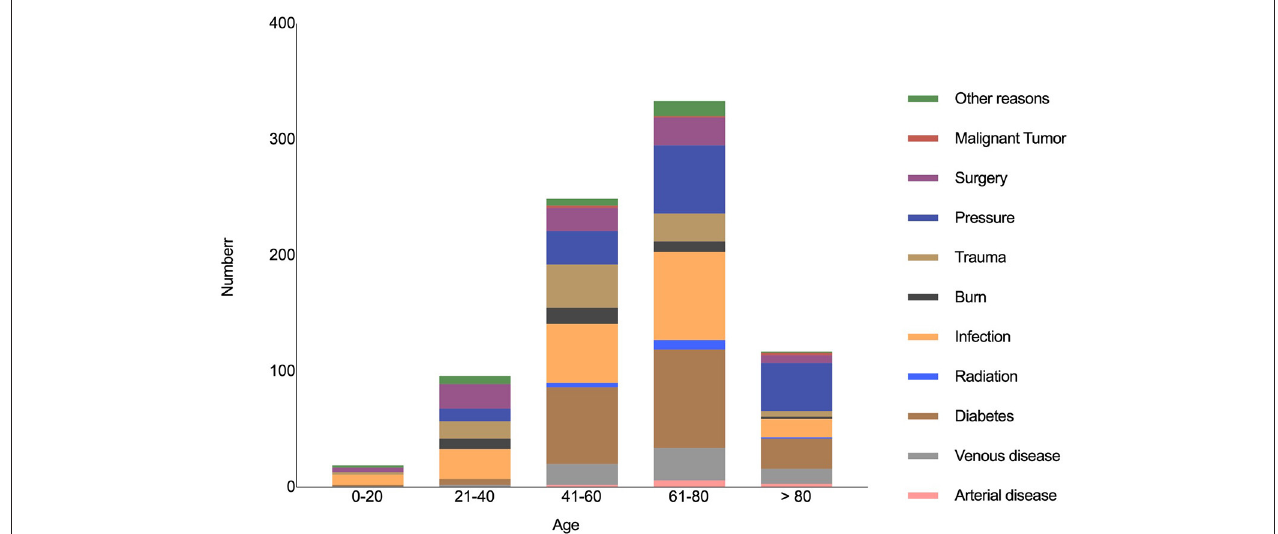
FIGURE 2 | The distribution of different causes in patients of different age groups.